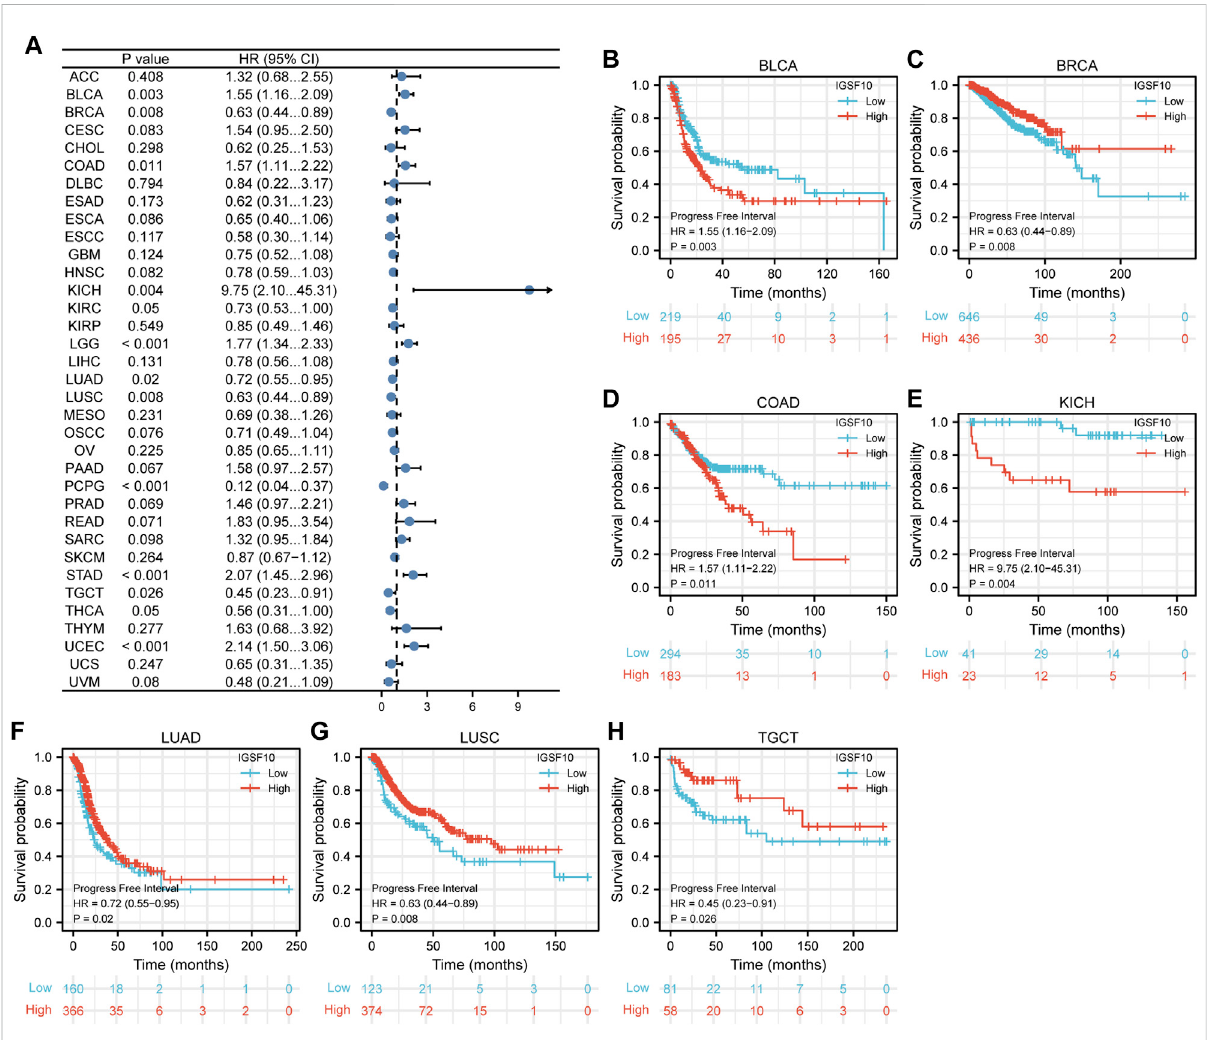
FIGURE 5 Correlations between the IGSF10 expression and progression-free interval (PFI). (A) Forest plot of results from the univariate survival analysis in pan-cancer for PFI. (B – H) Kaplan-Meier survival curves showed associations between the IGSF10 expression and